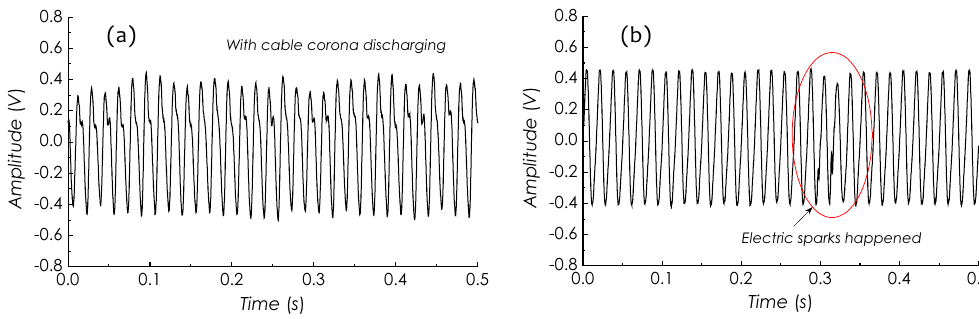
Figure 19. Measured E -field signal waveforms, ( a ) with corona discharges and ( b ) with electric sparks.